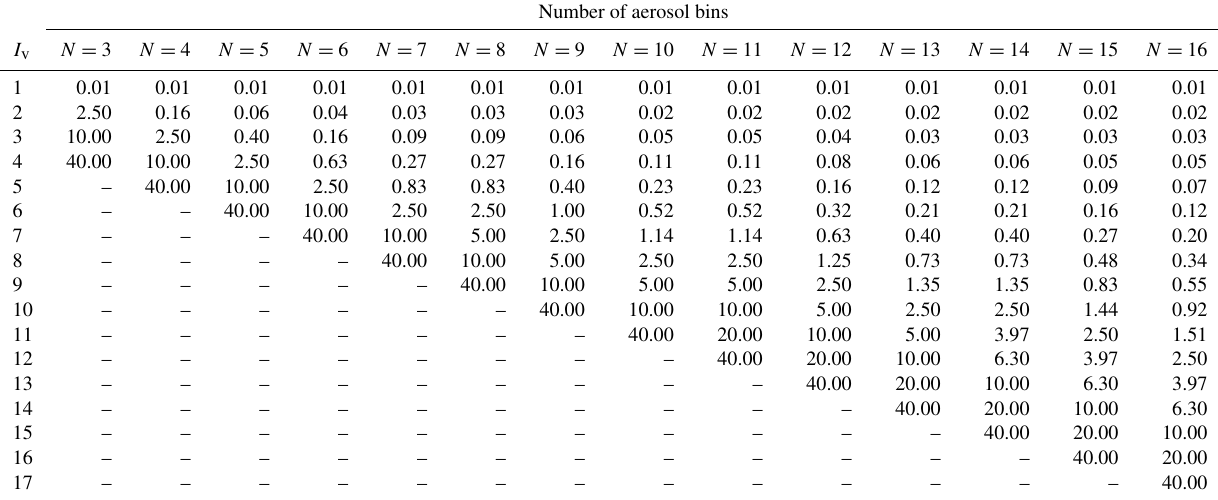
Table 2. Values of the diameter intervals, I v (µm), obtained for D min = 0 . 01µm, D max = 40µm, and 14 different values of bins ( N = 3 to N =